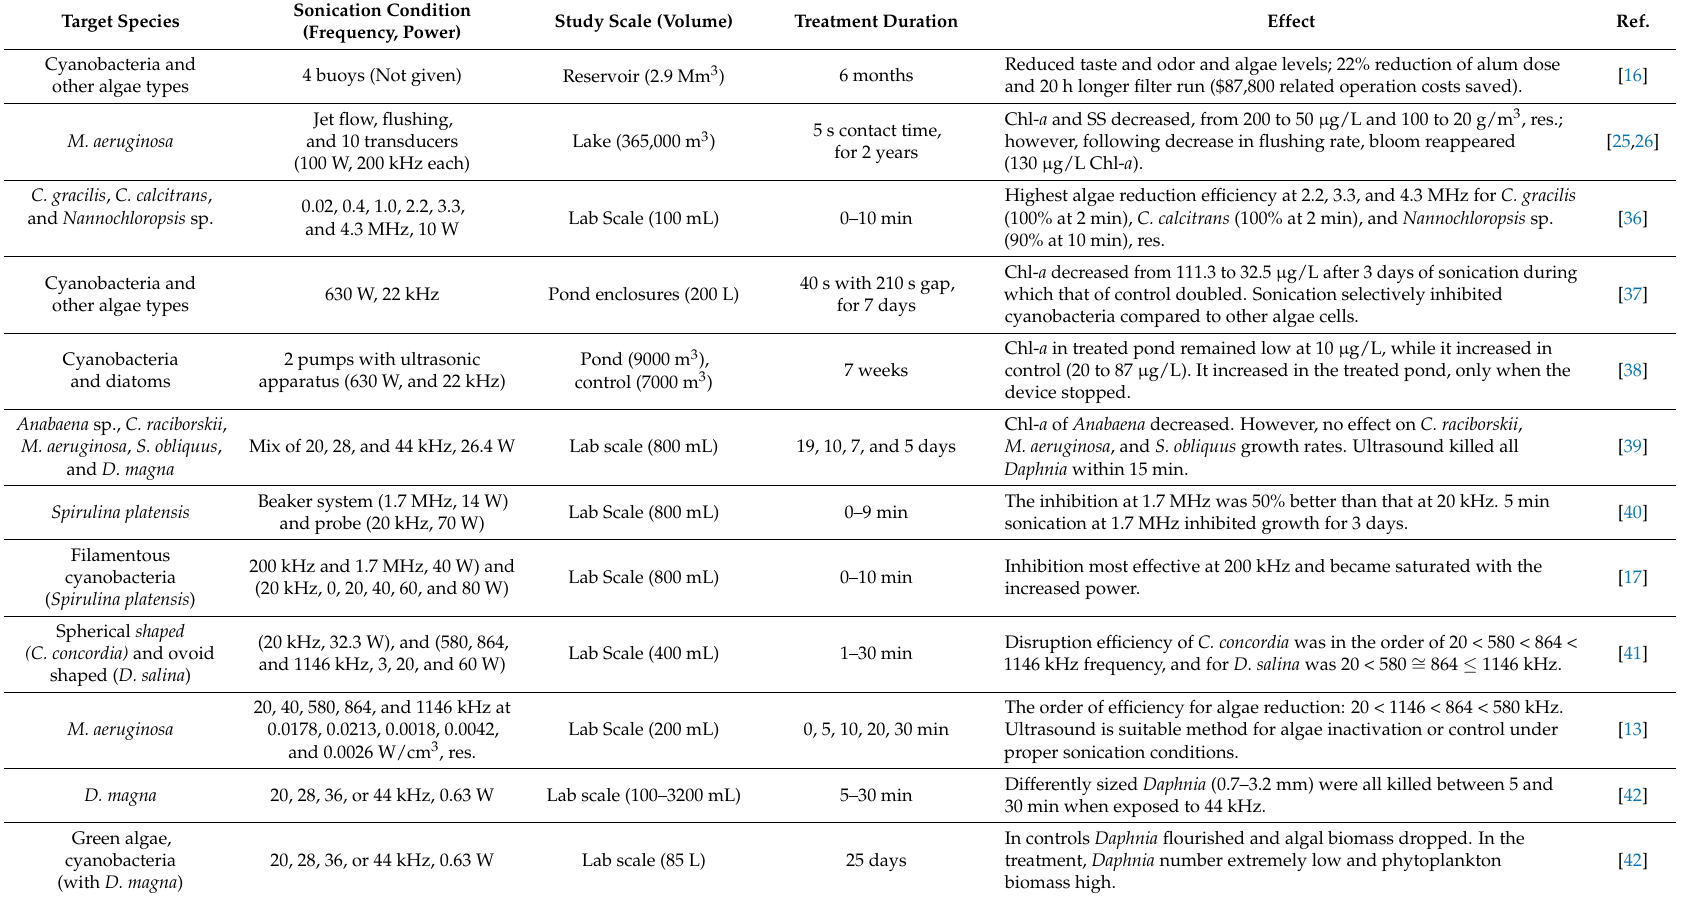
Table 1. Summary of laboratory and field ultrasonication studies for algae removal and